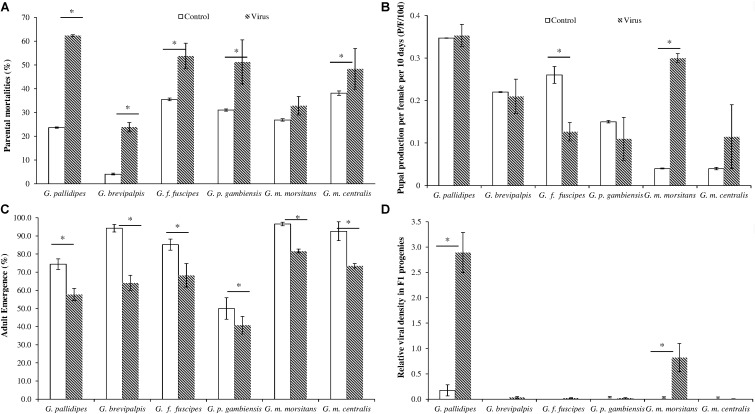
Impact of GpSGHV infection on fly survival and productivity. Teneral females were injected with GpSGHV suspension or PBS and mated with healthy males. Mortality (A) and pupal production per female per 10 days (p/f/10d) (B) were monitored weekly for 12 weeks. The rates of adult emergence and the prevalence of virus infections in the F1 progeny are shown in (C,D), respectively. The qPCR quantification data on viral copy numbers were normalized against the tsetse housekeeping gene, β-tubulin. ∗Indicate significant difference at the p = 0.05 level (Tukey HSD at the 95% family wise confidence level).